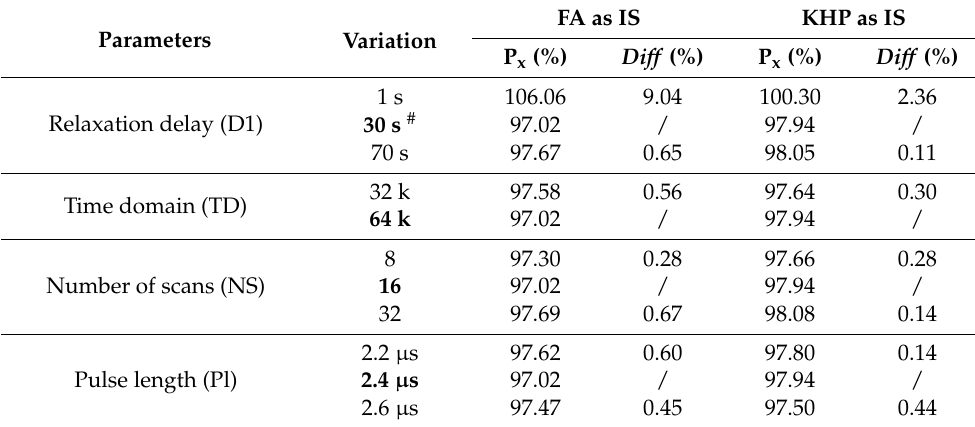
Table 4. Results of the robustness for the qNMR